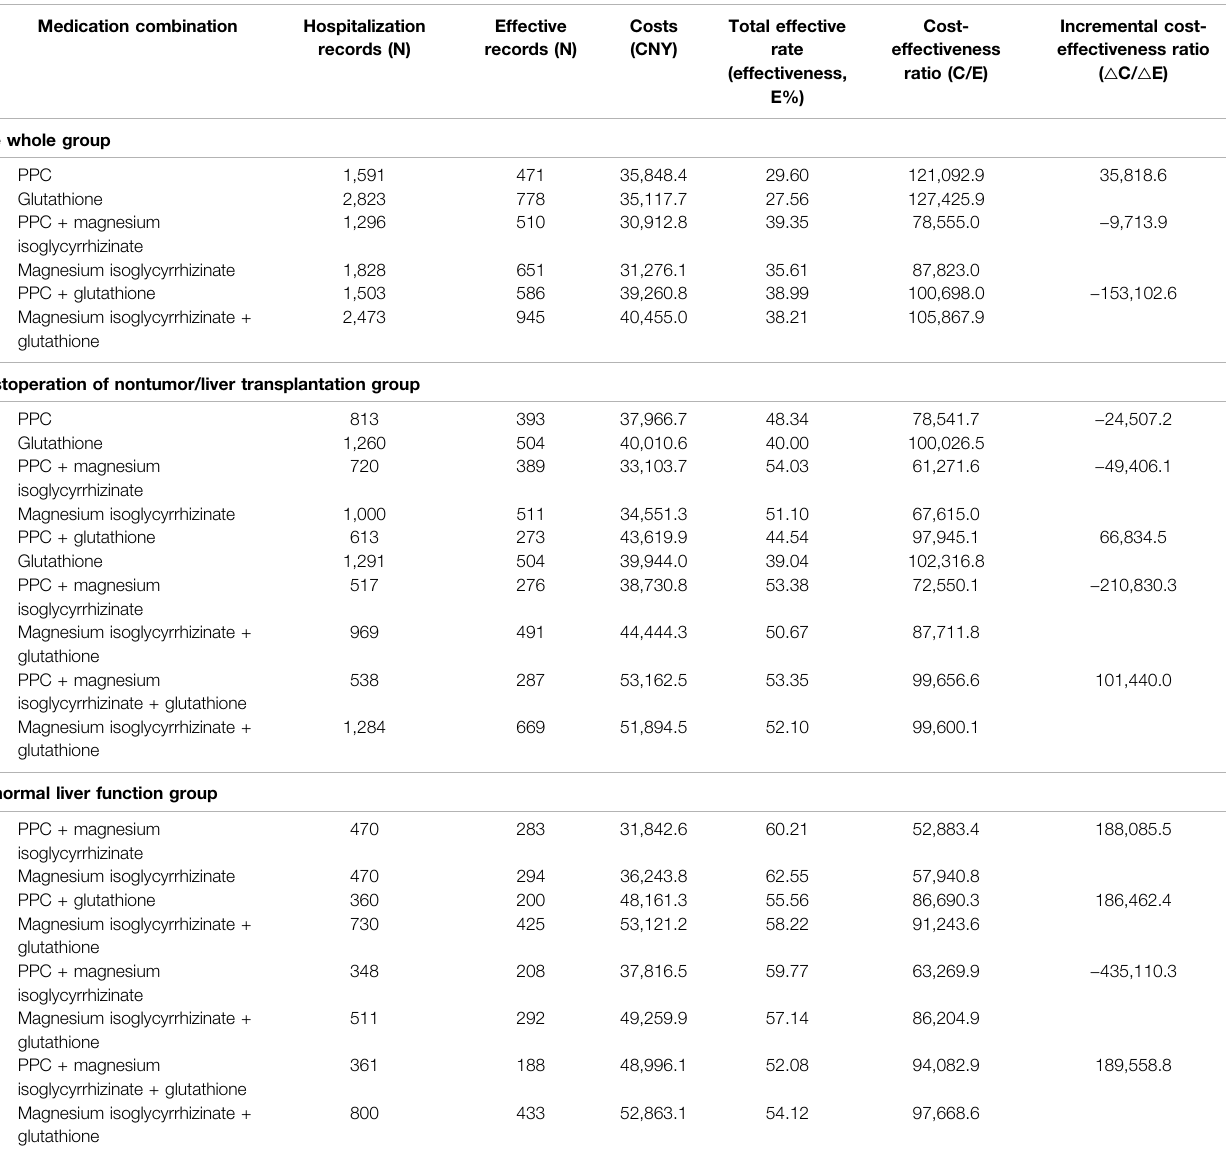
TABLE 6 | Cost-effectiveness analysis in phase Ⅲ No Medication